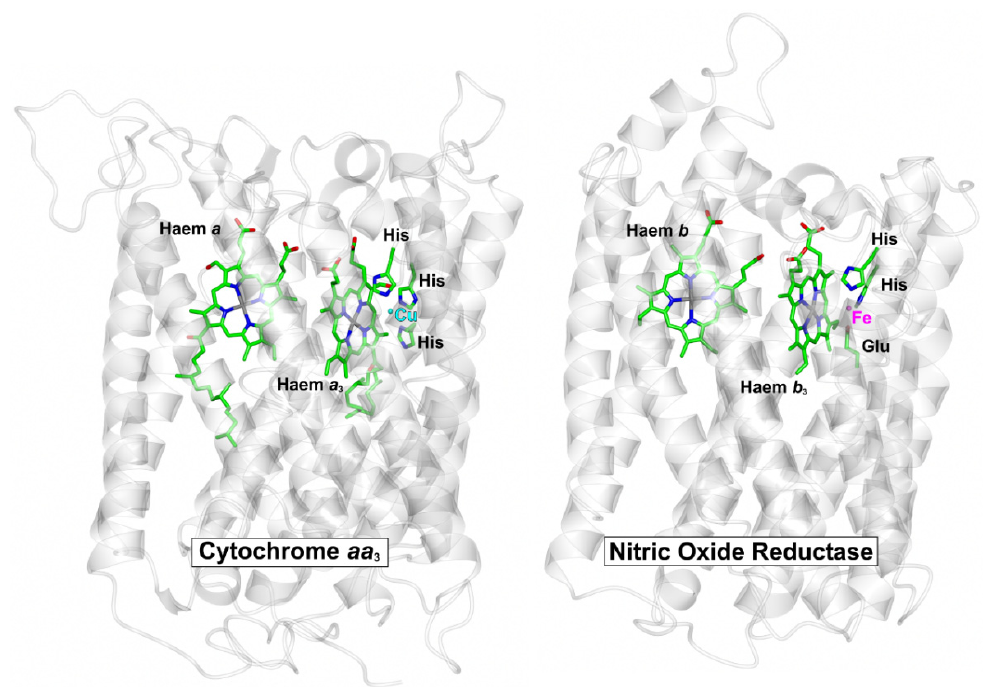
Figure 2. Core structures of O 2 -binding cytochrome aa 3 and NO-binding cNOR complex. The protein backbones for the core catalytic subunits for cytochrome aa 3 from P. denitrificans (pdbID = 3HB3, [83]) and the cNOR NO reductase from P. aeruginosa (pdbID = 3O0R, [75]) were superposed (RMSD = 2.88 Å). The central haem cofactors and the catalytic copper (Cu) and iron (Fe) centres are shown along with the sidechains that coordinate these metals. Peripheral subunits, cofactors and solutes have been omitted for clarity.